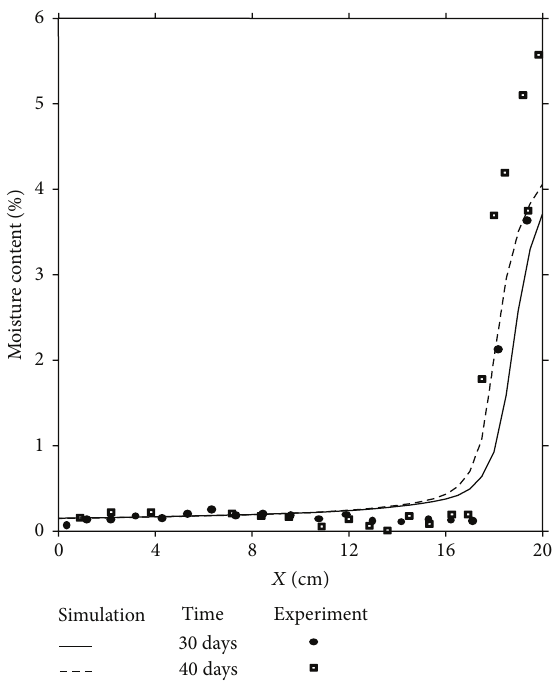
Figure 4: Moisture content distributions for 𝑡 = 30 days and 𝑡 = 40 days. Comparison between experiment and numerical simulation.